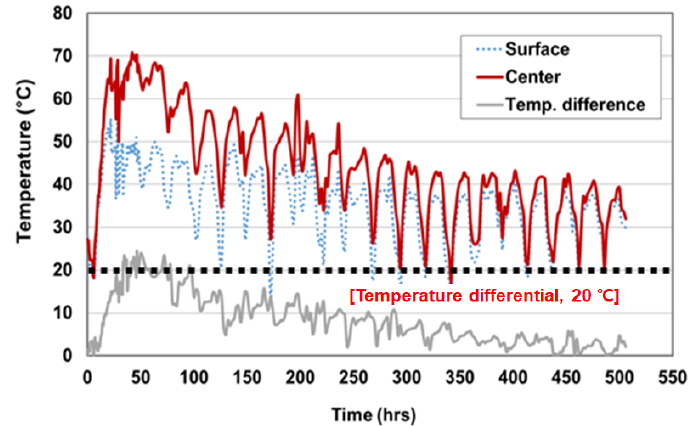
Figure 17. Cryogenic concrete with 65% GGBS and Polycarboxylate type